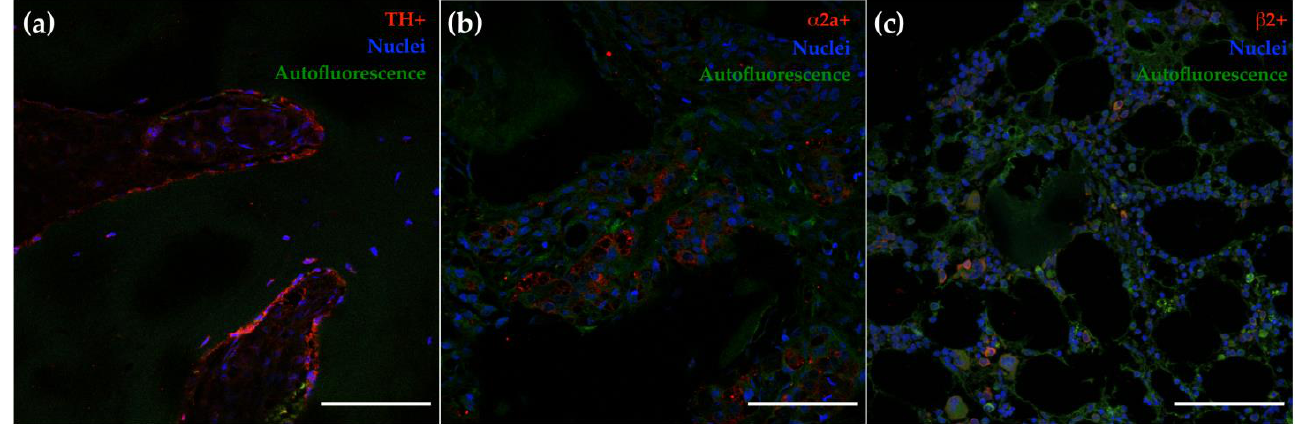
Figure 2. Representative images of immunofluorescence analysis on bone biopsies retrieved from BC patients. TH-positive ( a ), α 2a-positive ( b ), and β 2-positive ( c ) staining. Tissue autofluorescence is denoted in green. Scale bar = 100 µm.